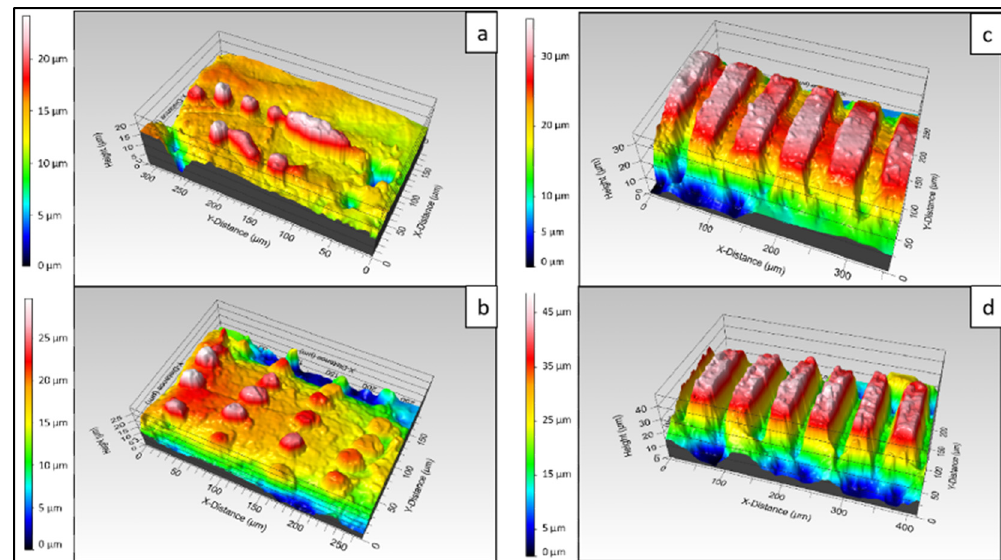
Figure 2. 3D profiles of PCL scaffold treated with the same fluence (0.08 J/cm 2 ) and rising applied laser pulses. ( a ) N = 1; ( b ) N = 2; ( c ) N = 5; ( d ) N = 10. As expected, the highest laser fluence (1.25 J/cm 2 ) formed a laser spot with the largest diameter with both N = 1 and N = 10 (Figure 3). However, the increase in the fluency in the range 0.08–0.42 J/cm 2 at N = 1 did not lead to a major change in the dimensions of the physical mark on the material.